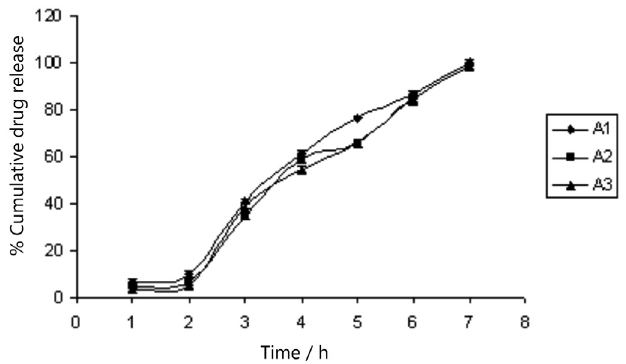
FIGURE 5 - Comparative results of in vitro release profile of hydroxypropyl methylcellulose (HPMC) with sodium alginate (SA)-based diclofenac beads.